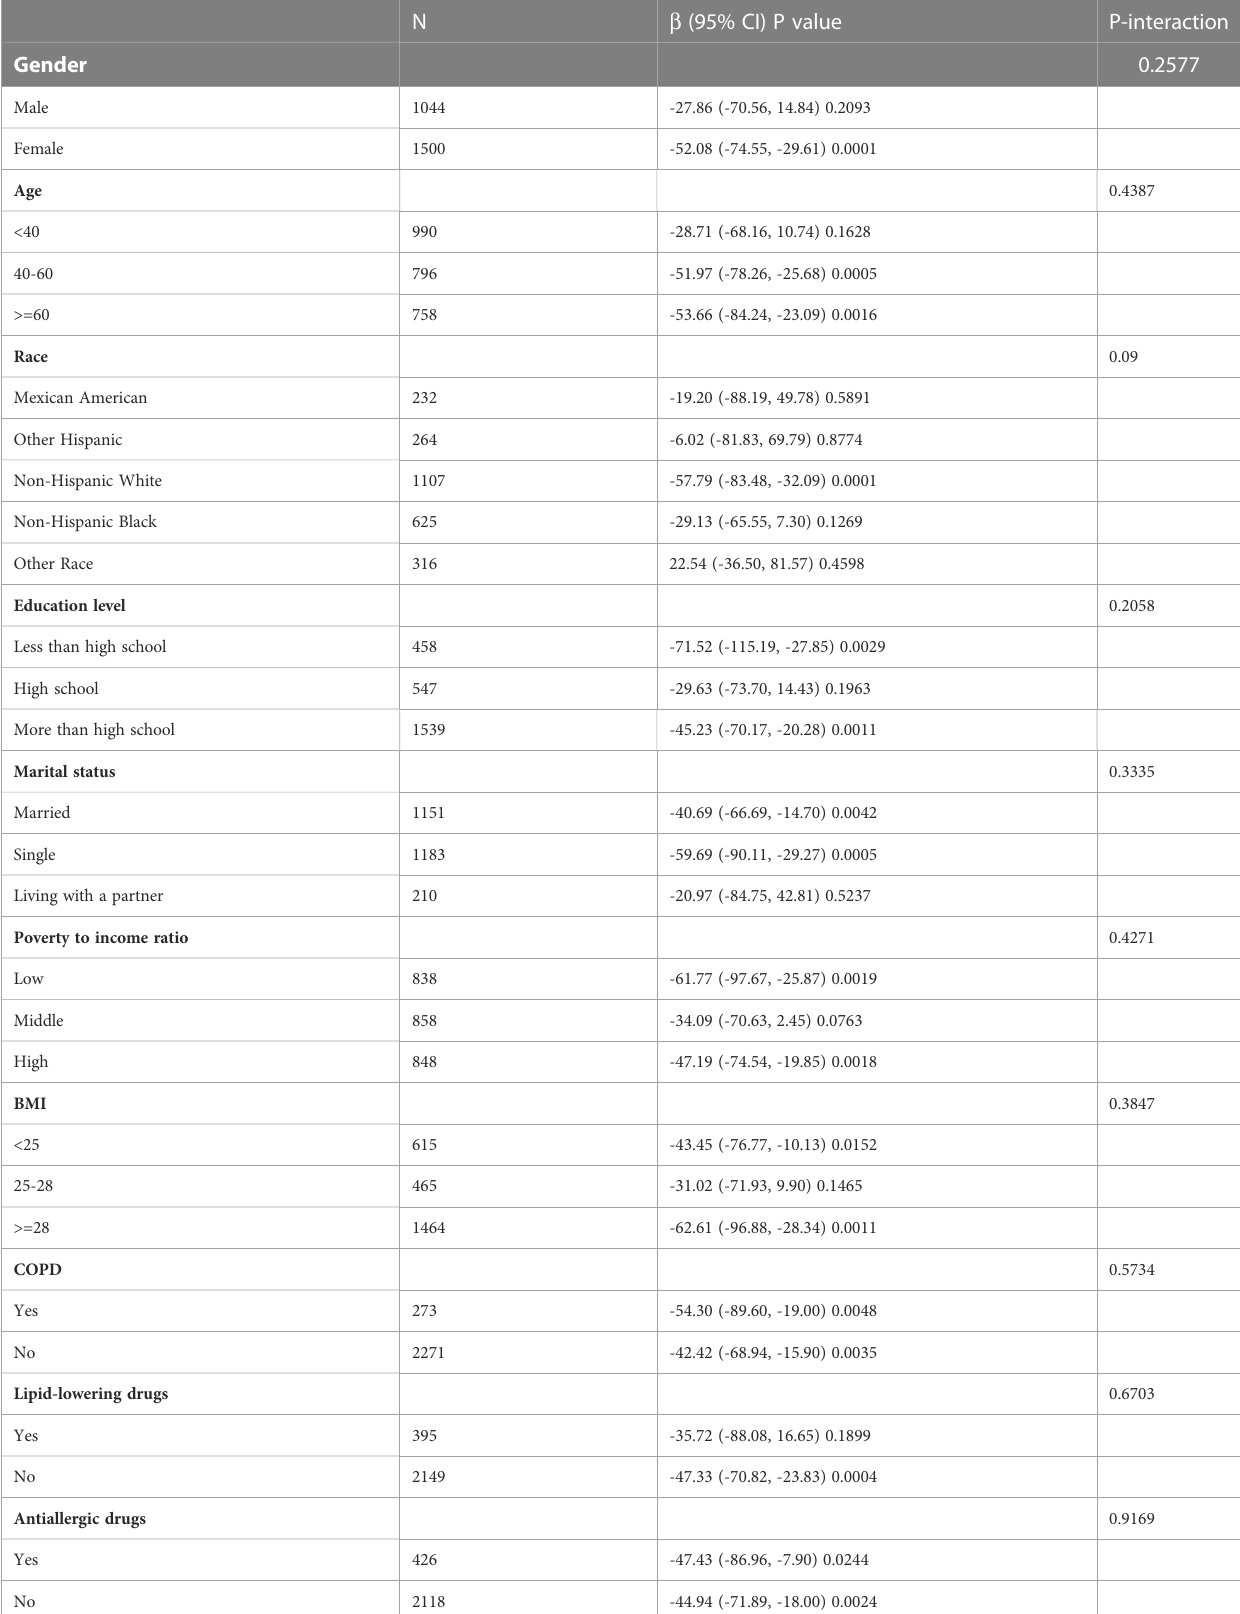
TABLE 4 Strati fi ed correlation of serum HDL-C on blood eosinophil counts in the predetermined and exploratory